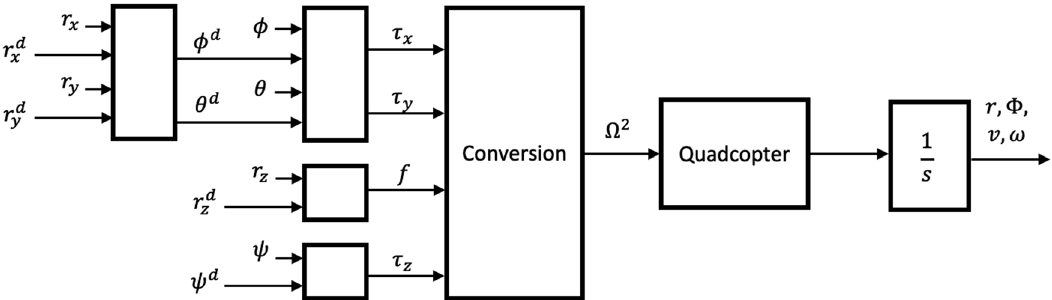
Figure 1: Basic cascade structure block diagram for